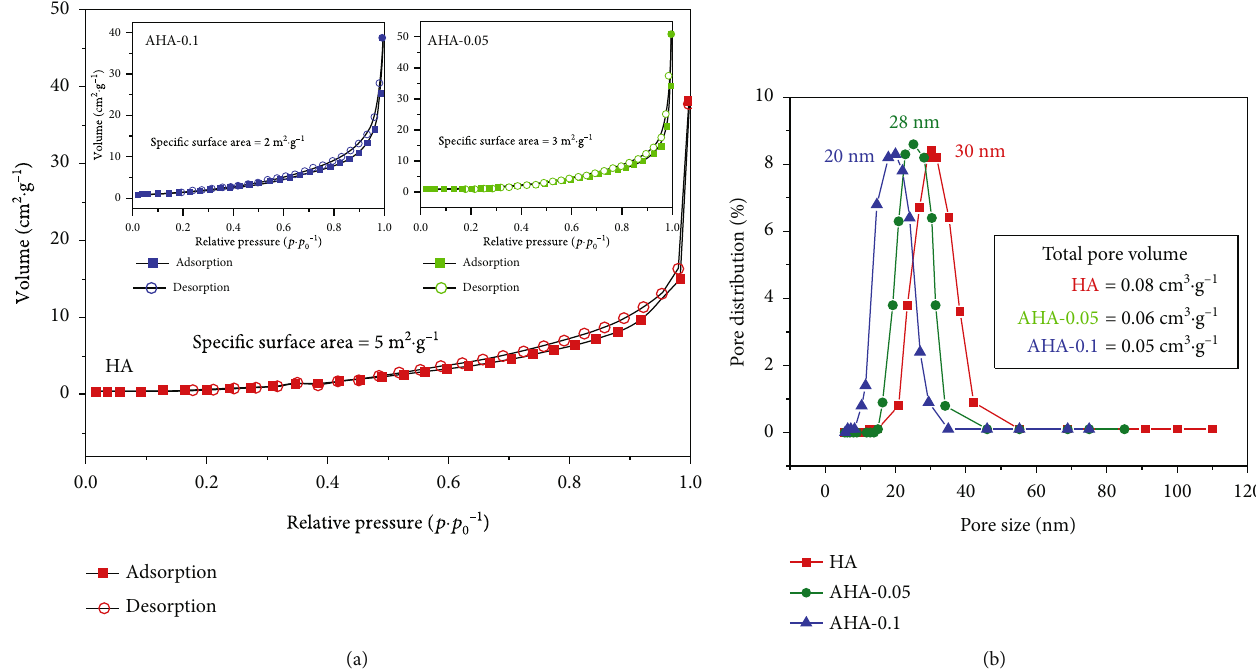
Figure 5: (a) Nitrogen sorption-desorption isotherm for HA, insert for AHA samples; (b) pore size distribution of HA, AHA-0.05 and